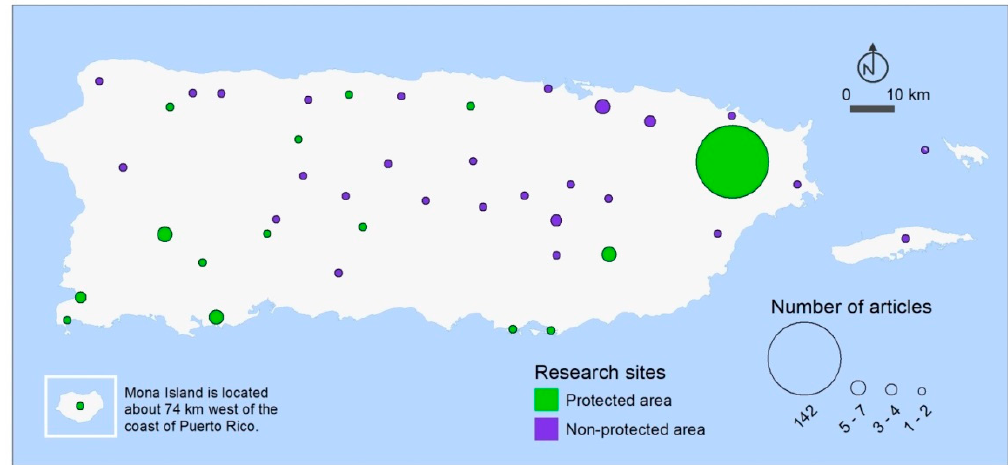
Figure 3. Location of study sites categorized by protection status and number of articles published.